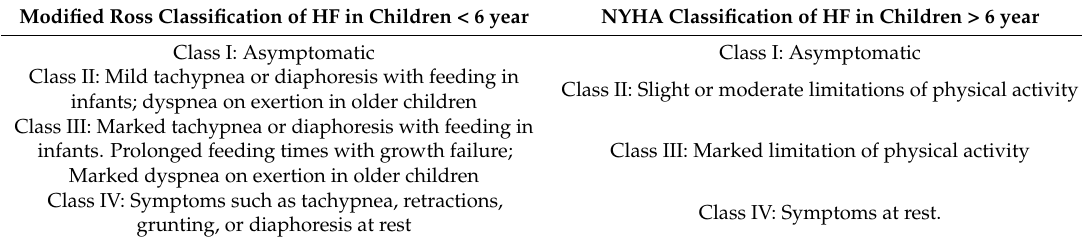
Table 3. NYHA and modified Ross classification of heart failure in